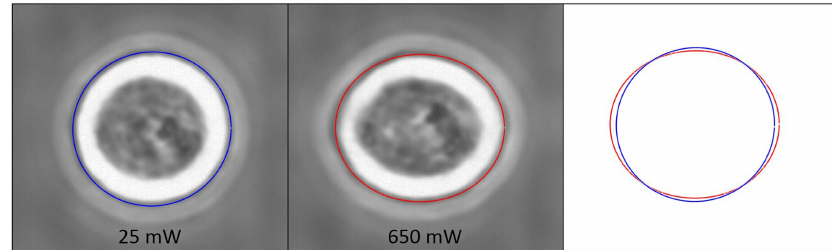
Figure 14. Optical stretching of a single MCF7 cell. The laser power is for each side and the cell contour is recognized by the edge detection algorithm in Figure